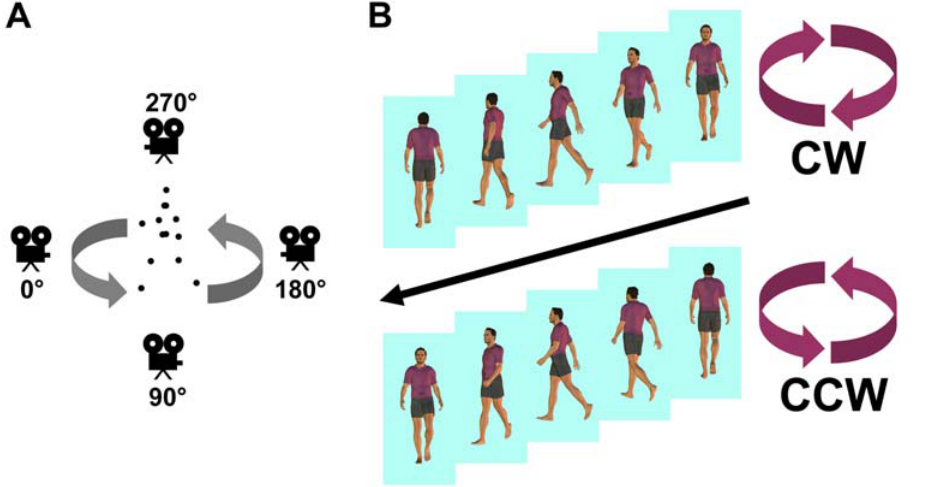
Figure 1. Stimulus design. (A) We created the stimulus (Movie S1) by plotting the 3-D coordinates of a standard biomotion walker, and rotating the viewing angle through one revolution during a single step-cycle. (B) As each frame of the sequence is compatible with two possible body configurations (via mirror reversal through the image plane), the walker appears to randomly reverse direction between clockwise and counter- clockwise when played over many cycles.